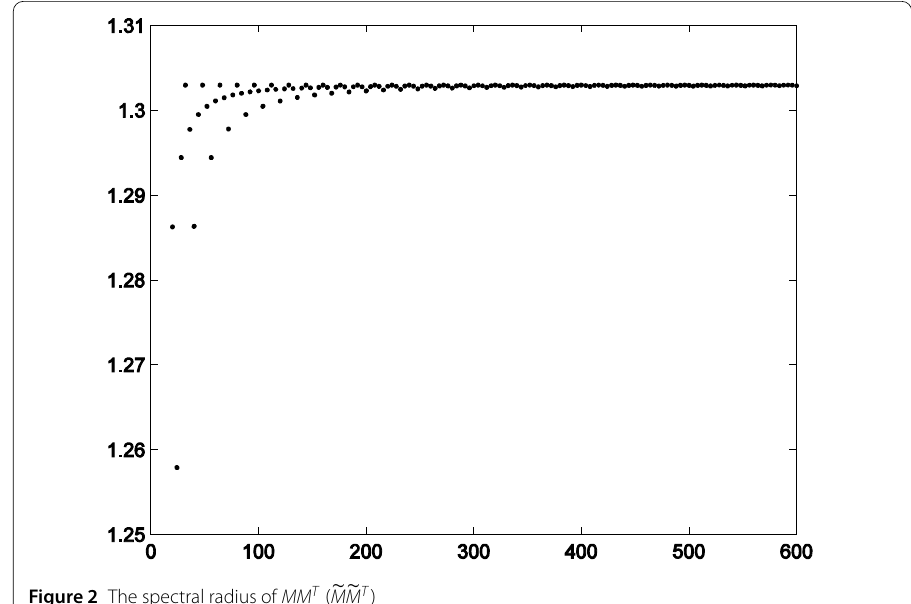
Figure 2 The spectral radius of MM T ( (cid:6) M (cid:6) M T